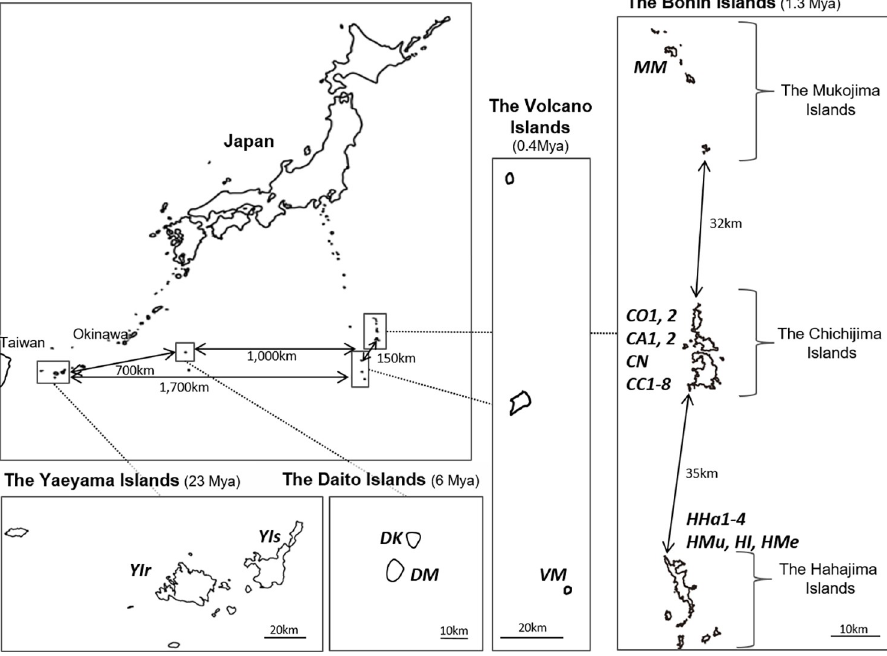
Fig 1. Location of the Bonin, Volcano, Yaeyama and Daito Islands. Bold italic letters show the Population ID of the sampled populations, shown in Table 1. Numbers in the parentheses are approximate age of islands used in the lmer analyses. Maps were drawn by ArcGIS using the coast line data downloaded from the Geographical Survey Institute of Japan (https://nlftp.mlit.go.jp/ksj/gml/datalist/KsjTmplt-C23.html), under a CC BY license, with permission from the Geographical Survey Institute of Japan, original copyright